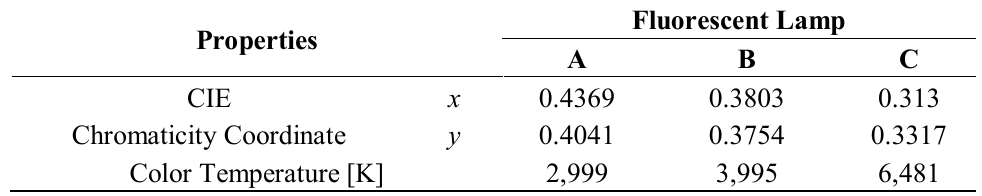
Table 1. Measured CIE Chromaticity coordinates and color